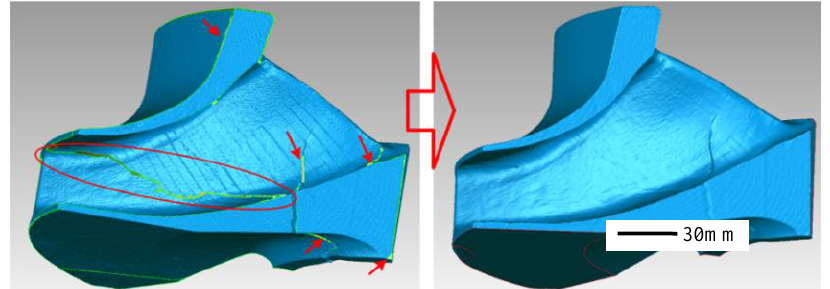
Figure 8. Schematic diagram of multi-viewed piecing-together.